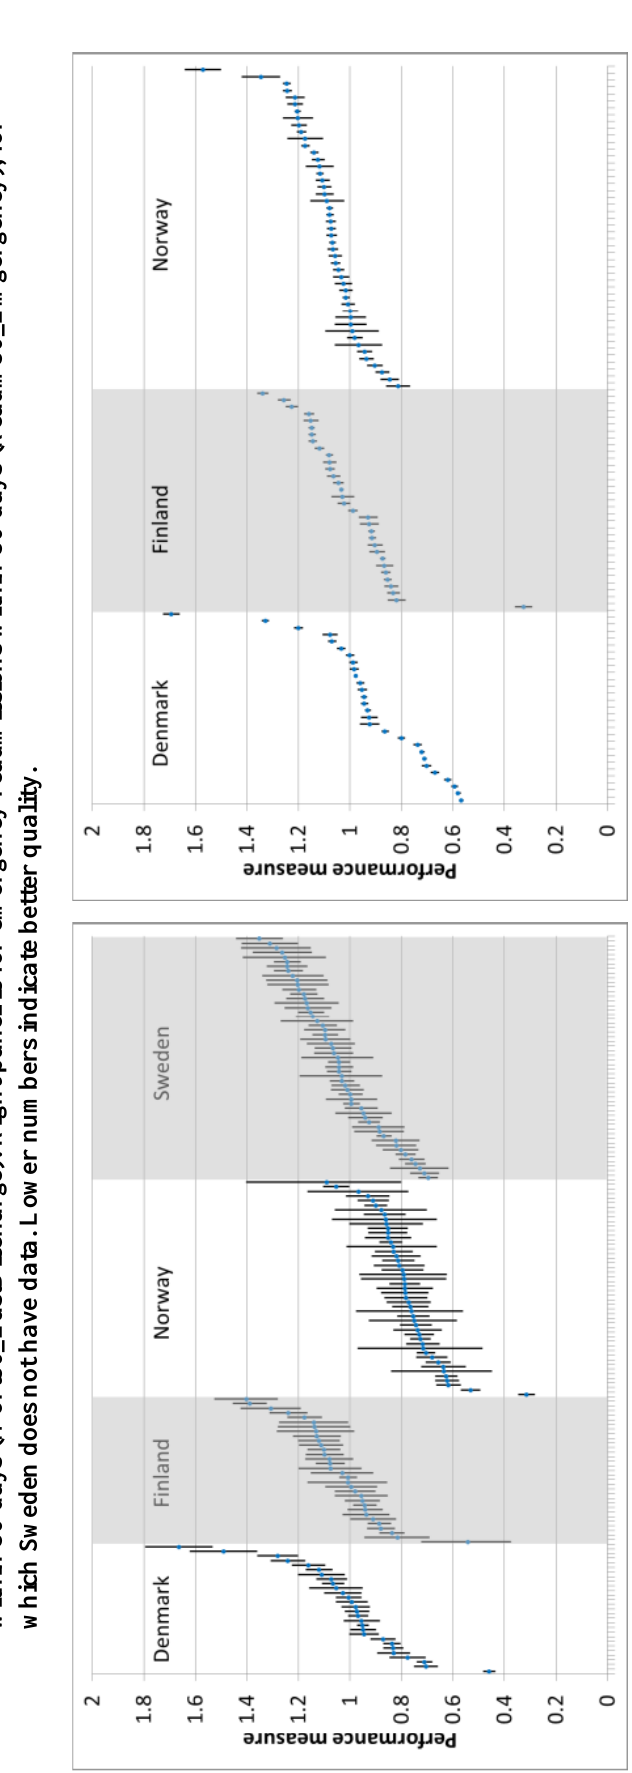
y li t a qu er tt e b e a t c nd i i s er b m nu er w o L a . a t d e av h o t n s e o d n e d e w S h c h i w